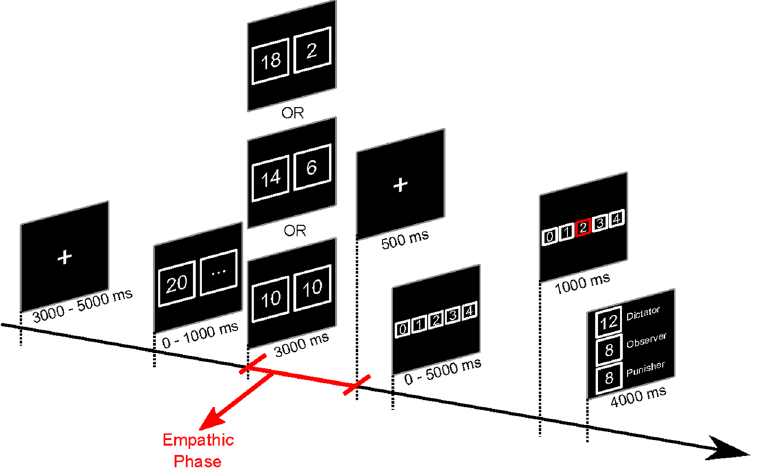
Figure 2. Timeline of the Third-Party Punishment paradigm for one block. This timeline is equal in the PC and human conditions. First, a fixation cross appears on the screen for a randomly selected period from 3000–5000 ms. Then, Player A is asked to make his decision among three alternatives (fair: 10 points to player A, 10 to player B; unfair: 14 points to player A, 6 to player B; hyperunfair: 18 points to player A, 2 to player B) in less than 1 second. Player A’s decision is then shown to all players for 3 seconds (empathic phase). Player C is then asked to select 0 to 4 punishment points within 5 s. For every punishment point invested by Player C, 3 points are subtracted from Player A’s payoff, and 1 point is added to Player B’s payoff. The trial ends, showing (4 seconds) a window containing the scores of the current trial. This scheme was repeated for 210 trials (half for human and half for PC condition), divided into blocks of 30 trials